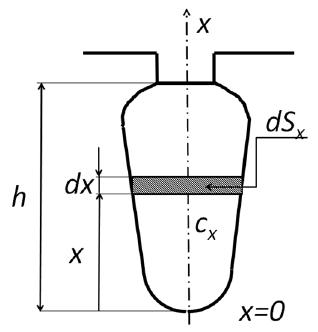
Figure 1. Discretization of the rotor cage bar.